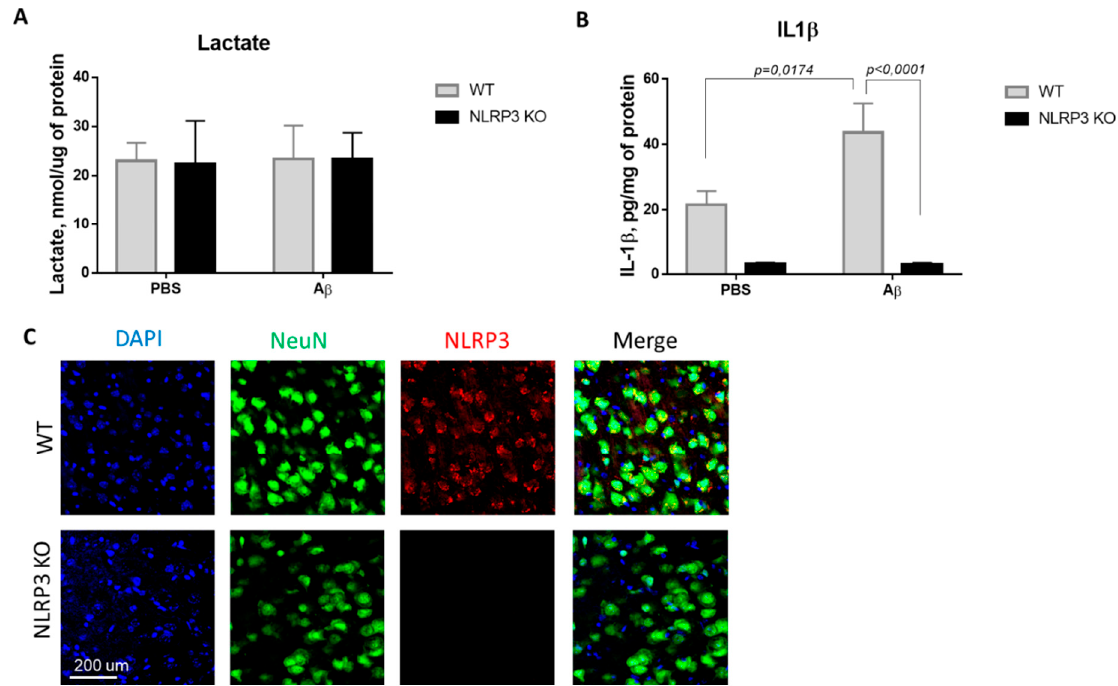
Figure 2. Results of measurements of ( A ) lactate in homogenates of the amygdala; ( B ) interleukin 1 β in homogenates of the amygdala. ( C ) Representative confocal images of NLRP3-expressing neurons and stained for DAPI (blue), NeuN (green), NLRP3 (red), signal overlay (merge). Scale Bar 200 μ m. NLRP3 KO KO —NLRP3 knockout mice, A β —amyloid beta injection, PBS—phosphate buffered saline injection (sham operation).